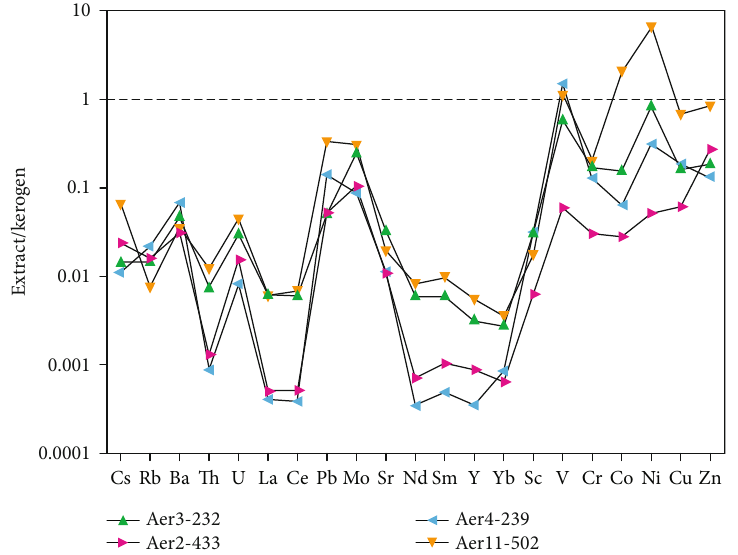
Figure 13: Trace elements in extract fraction of mudstones normalized to corresponding kerogen fraction